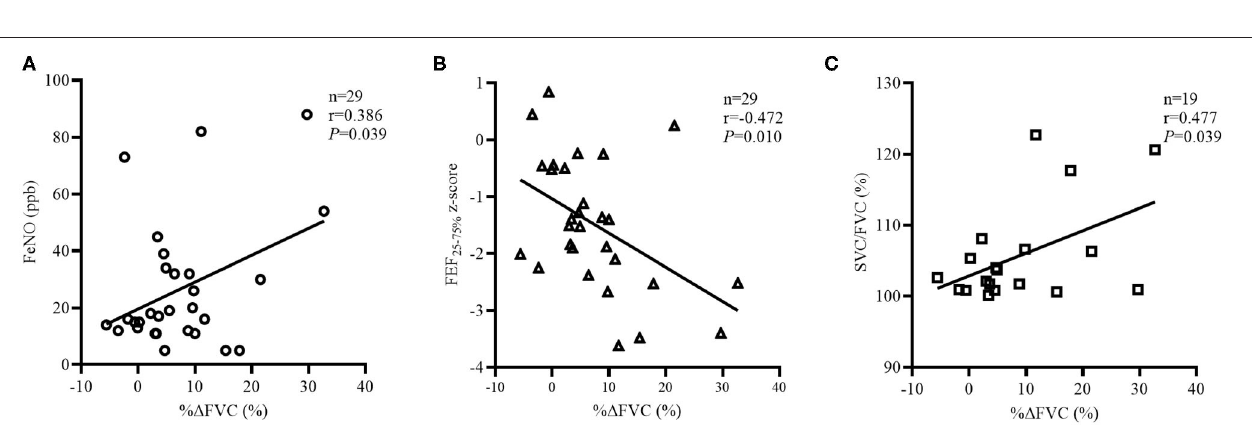
FIGURE 4 | Factors related to FVC z-score in the “restricted” group. The correlation coefficients were obtained by Pearson’s correlation. (A) Changes in total IgE related to the FVC z-score values. (B) Changes in FEF 25 − 75 % z-score related to the FVC z-score values.